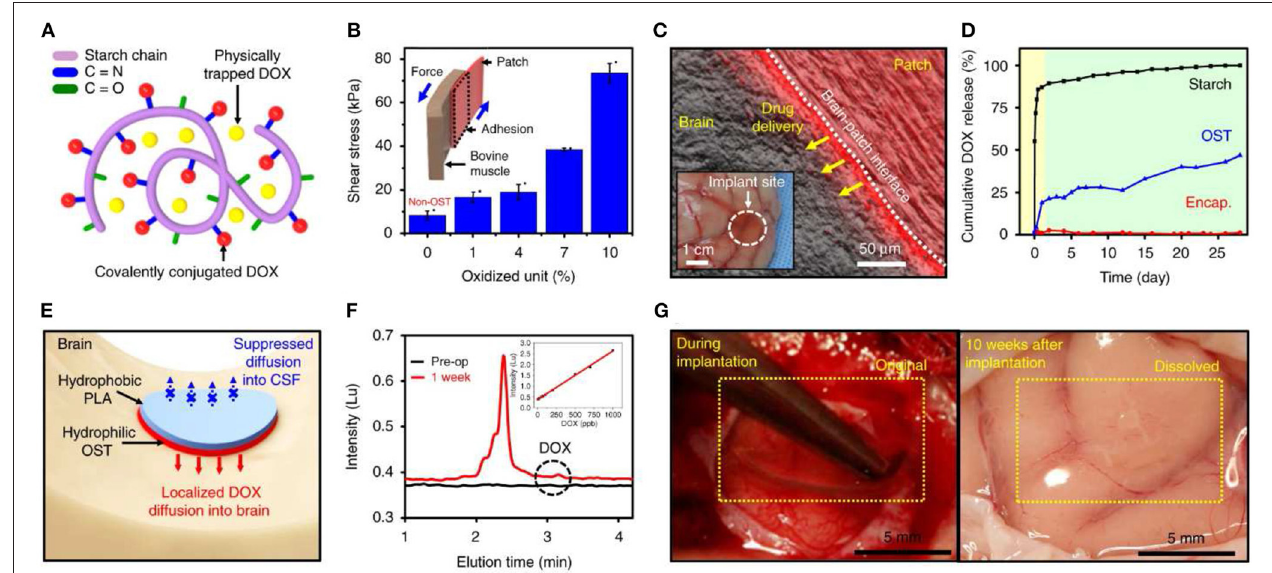
FIGURE 6 | Bioresorbable electronic patch (BEP) implant for controlled drug release. Reproduced under the terms of the Creative Commons Attribution License (Lee et al., 2019). (A,B) The patches are fabricated from a drug-loaded (doxorubicin) oxidized starch (OST) reservoir, and an electronics-containing compartment made from Mg (conductor), PLGA (dielectric), and PLA (encapsulation) which is bound to it. (C) Wireless control mediates drug delivery into neural tissue. (D-F) Doxorubicin release into tissue occurs over a period of days. (G) The entire implant becomes fully resorbed within 10 weeks of implantation, leaving no adverse reaction in the nearby